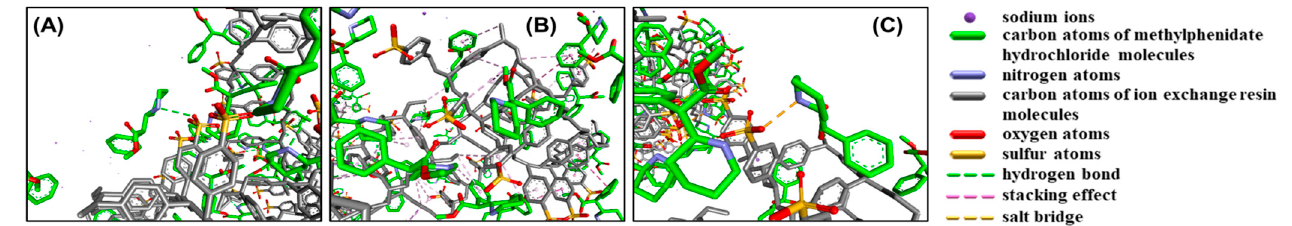
Figure 8. Simulation of the interaction between drugs and ion exchange resins.